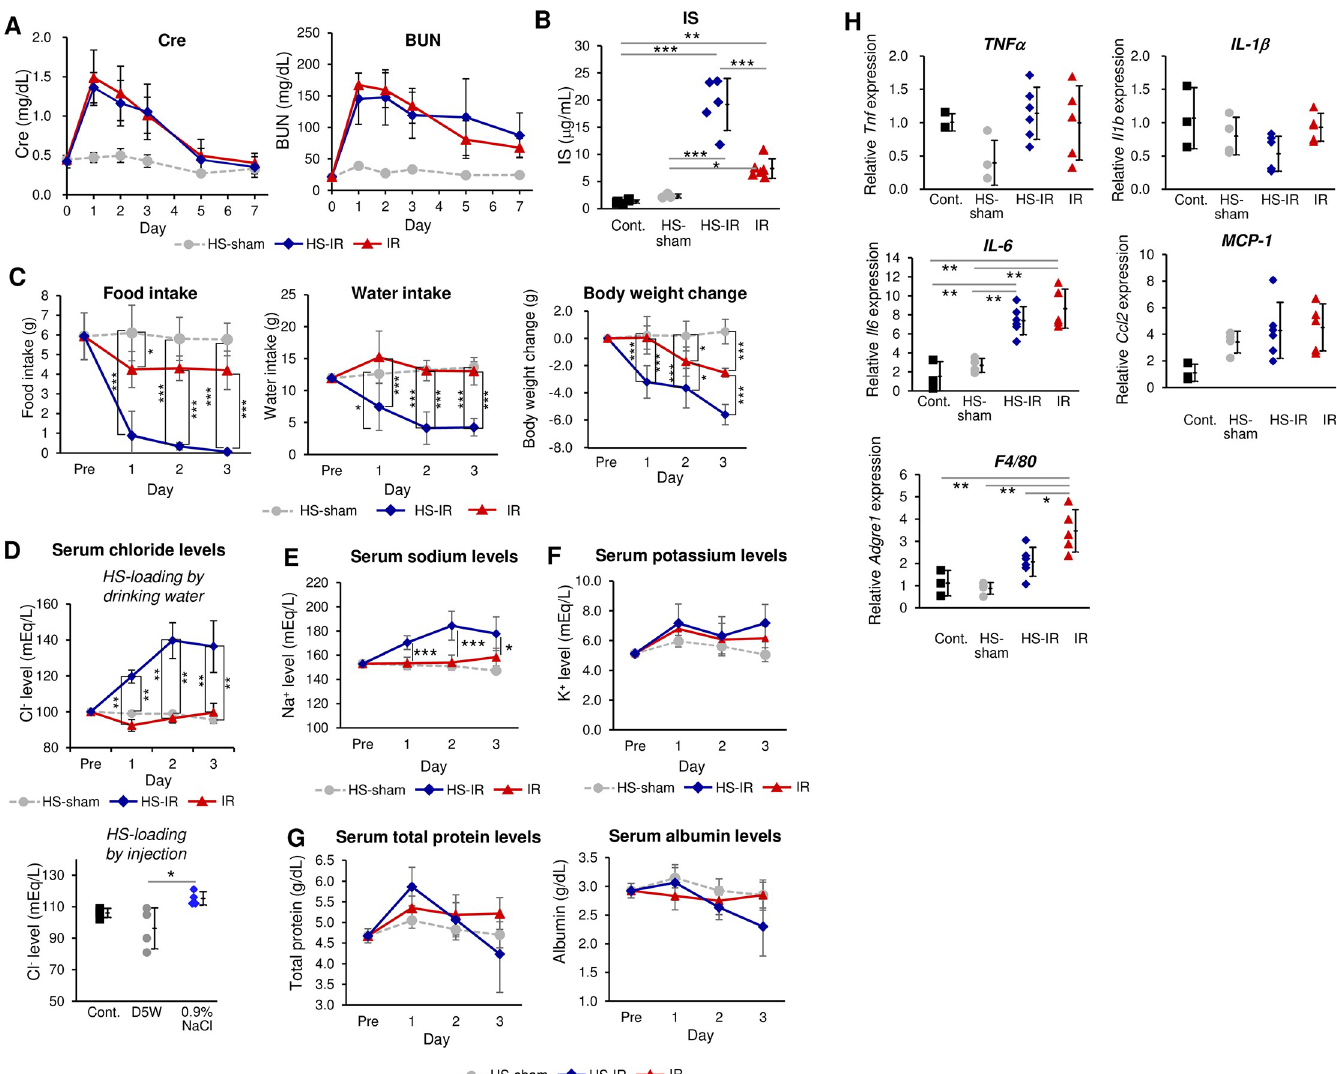
Fig 2. How high salt exacerbates AKI. (A) Serum Cre and BUN levels after IR. HS-sham ( n = 4), HS-IR ( n = 6), and IR ( n = 5) mice were analyzed. No significant differences between HS-IR and IR were detected at any time point with Welch’s t -test. (B) Serum IS levels on day 3 after IR/sham. HS-IR ( n = 5) and IR ( n = 6) mice were analyzed. Statistics: Multi-way ANOVA with Bonferroni’s adjustment. (C) Food intake, water intake, and body weights. Values relative to those before IR in HS- sham ( n = 4), IR ( n = 5), and HS-IR ( n = 6) mice are presented. Statistics: Welch’s t -test with Holm’s adjustment. D. Serum chloride levels. Results of HS-sham ( n = 4), IR ( n = 5), and HS-IR ( n = 6) (upper panel), results of IR mice injected with D5W or 0.9% NaCl ( n = 4 each) at day 3 after IR/sham and in control mice ( n = 3) (lower panel). Statistics: multi-way ANOVA followed by Bonferroni’s post hoc test (upper panel). One-way ANOVA followed by Holm’s post hoc test (lower panel). (E) Serum sodium and (F) potassium levels. Values after IR. HS-sham ( n = 4), HS-IR ( n = 6), and IR ( n = 5) mice were analyzed. Statistics: Welch’s t-test with Holm’s adjustment. � : HS-IR v. s. IR. G: Serum levels of total protein and albumin. Sera from HS-sham ( n = 4), IR ( n = 6), and HS-IR ( n = 6) ICR mice were analyzed on day 1 to day 3 after IR. Values were also tested in ICR mice without IR or HS-fed as “Pre” (n = 4). Statistics: Welch’s t -test with Holm’s adjustment. H. QPCR analysis . mRNA expression of various pro-inflammatory genes in HS-sham ( n = 4), IR ( n = 5), and HS-IR ( n = 6) mice on day 3 after IR/sham. The values from the mice without any treatment (Cont.) are also presented ( n = 3). Statistics: one-way ANOVA followed by Holm’s post hoc